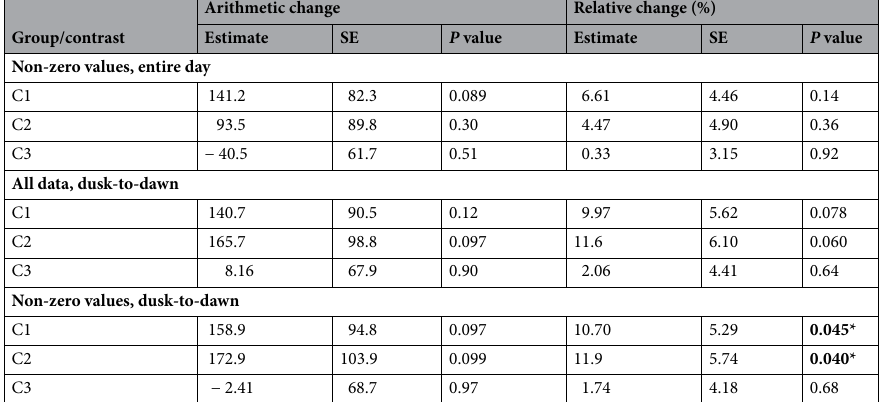
Table 4. Analysis of mean hourly activity with (‘all data’) and without (‘non-zero’) minutes when activity was zero. Arithmetic change and relative change (percentage) for three contrasts that compare treatment groups. Results shown for non-zero activity across the whole day; all activity over the dusk-to-dawn time period; and non-zero activity over the dusk-to-dawn time period. Estimate = change from baseline in hourly activity counts with robenacoxib relative to placebo (positive values indicate greater activity when on robenacoxib). SE standard error. The contrasts were: C1 (contrast 1) = treatment group PP compared against groups RR and RP following 3 weeks of treatment; C2 (contrast 2) = treatment group PP compared against group RR following 6 weeks of treatment; C3 (contrast 3) = treatment group RP compared against RR for change in activity between weeks 3 and 6 of treatment. P = placebo; R = robenacoxib. *Significance at 0.05 level.